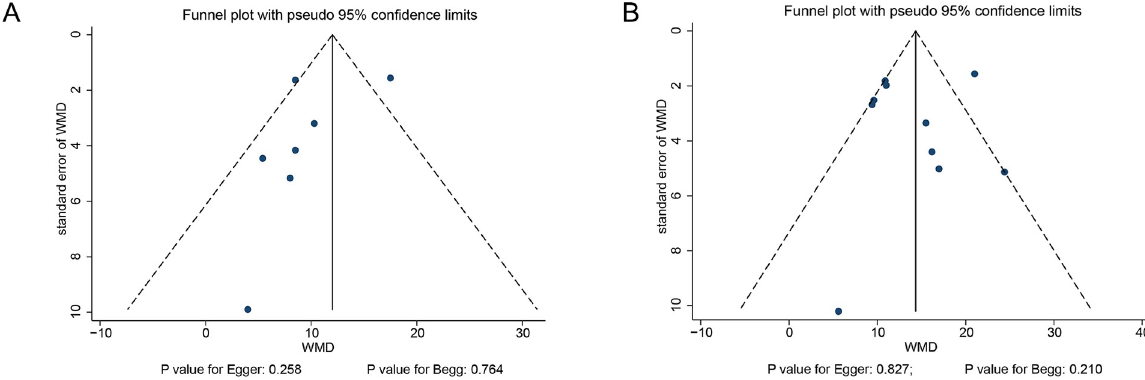
Fig 4. Funnel plots for initial rSO2 (A) and mean rSO2 (B)